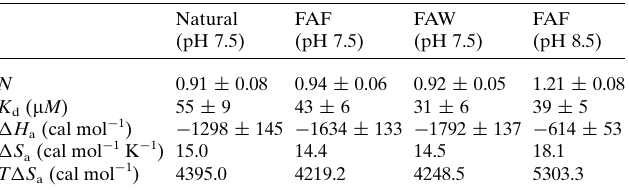
Table 2 Thermodynamic parameters obtained from ITC titration of natural (cid:2) -lactoglobulin and its mutants with DSM at 293 K. N , stoichiometry; K d , dissociation constant; (cid:2) H a , enthalpy change; (cid:2) S a , entropy change. The errors shown are the errors of fitting the data to the one set of binding sites